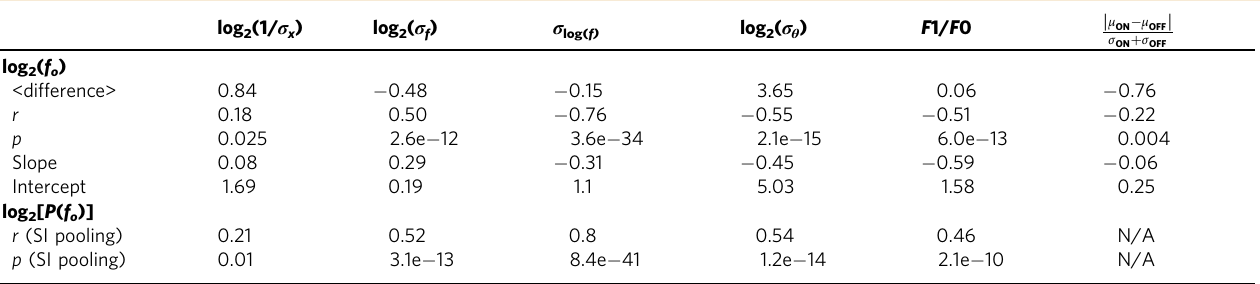
Top 5 rows: Joint statistics between the log 2 ( f o ) and other variables in this study. The fi rst four column symbols — σ x , σ f , σ log( f ) , σ θ — are RF width (°), linear SF bandwidth (c/°), logarithmic SF bandwidth (octaves), and orientation bandwidth (°). The last two column symbols are spatial phase selectivity and ON – OFF overlap. As indicated, log 2 was taken for parameters in columns 1, 2, and 4, prior to comparing with log 2 ( f o ). The fi rst row is the average difference between the column variable and log 2 ( f o ). The second and third rows are the Pearson correlation coef fi cient and p value relating the column variableto log 2 ( f o ). Thefourth and fi fth rowsare the slope andintercept of the linear fi t,wherelog 2 ( f o )is the domain.Bottom 2rows:The fi rst fi vecolumn parametershave a predictionfrom the pooled scale invariance model, which is a function of f o , generically identi fi ed as P ( f o ) on the left. Speci fi cally, the prediction of the variables in columns 1 – 5 are given by Eqs. (5), (7) – (9) and (6), respectively. The Pearson correlation coef fi cient and p value between the model predictions and data are given in the bottom two